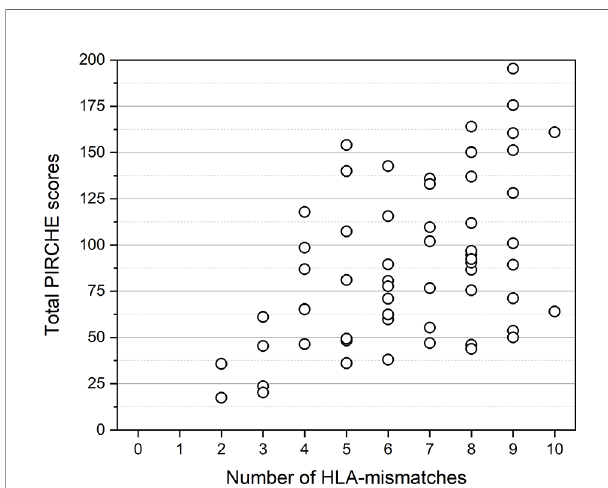
FIGURE 2 | DistributionoftotalPIRCHEscorescomparedtototalHLA-mismatches. PIRCHEscoresandthenumberofHLA-mismatcheswerecalculatedfromHLAclassI (HLA-A, B,C) andHLA class II (HLA-DR,DQ) mismatches. Median PIRCHE scores for 4, 5, 6, 7, 8, 9, and 10 HLA-mismatches were 76.15, 81.07, 77.63, 101.97, 94.66, 114.56, and 112.45, respectively.